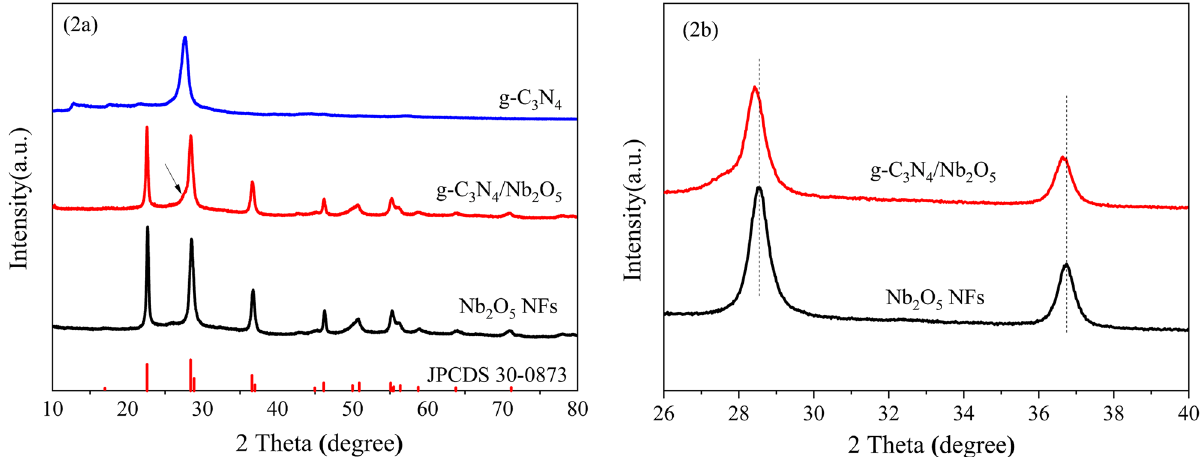
Figure 2. ( a ) XRD patterns of g-C 3 N 4 , Nb 2 O 5 NFs and g-C 3 N 4 /Nb 2 O 5 heterojunction and ( b ) enlarge of 2 theta scale at 26°–40° region of